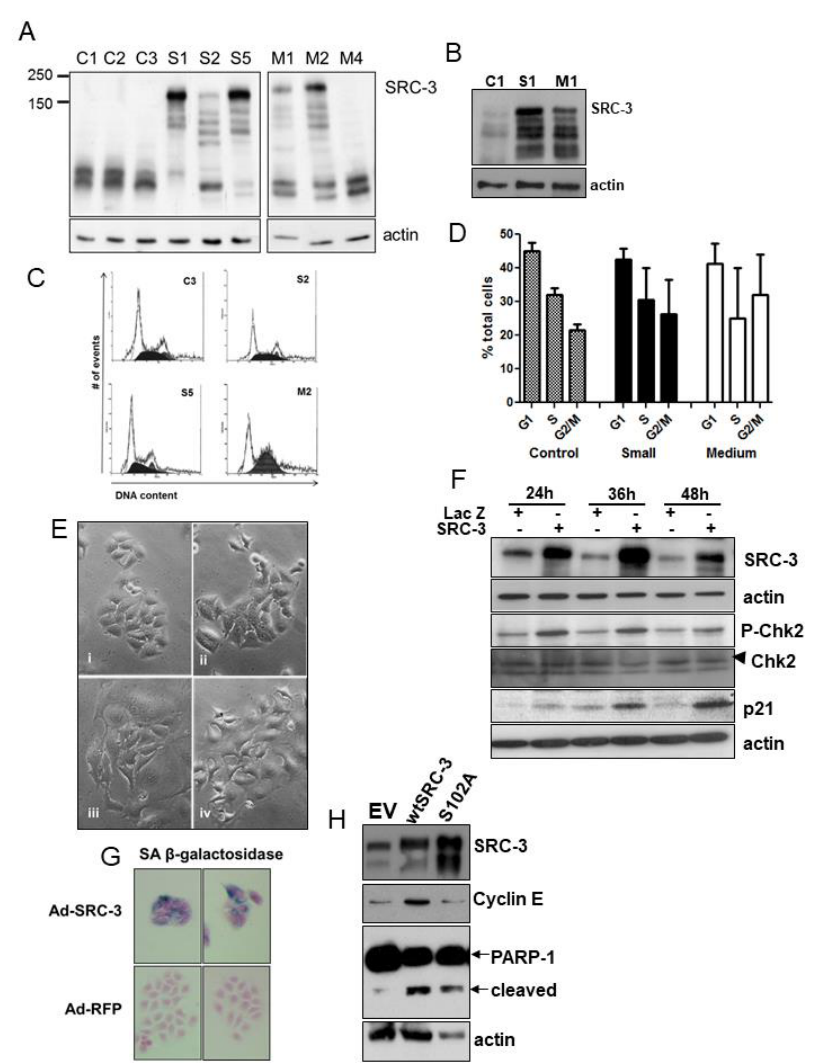
Figure 2. Establishment of SRC-3-overexpressing MCF-7 cells. ( A ) Immunoblot analysis showing SRC-3 protein expression in MCF-7 cells transfected with pCMX-RAC3 (SRC-3) or pcDNA3 and selected for puromycin resistance. SRC-3 stable cells were categorized according to the relative size of the average cell within a colony prior to expansion. Examples of clones that survived at least one passage are shown: control pcDNA3 cells (1,2,3), small-sized SRC-3 transfected clones (S1,2,5) and medium-sized SRC-3 clones (M1,2,4). Large cell clones did not survive passage. ( B ) Immunoblot of original clones showing SRC-3 expression relative to empty vector-transfected control. ( C ) Flow analysis of DNA content derived from the indicated clones. ( D ) DNA content graphs derived from the analysis of several clones. Bars are SD of means from: pcDNA control ( n = 4), SRC-3 small ( n = 15), SRC-3 medium ( n = 4). ( E ) Phase-contrast images of control pcDNA3- and pCMX-RAC3- (SRC-3) transfected MCF-7 cells. Panels are (i) Control clones, (ii) small SRC-3-overexpressing clones, (iii and iv) medium SRC-3-overexpressing clones which were enlarged and flat with abundant cytoplasm. ( F ) Cell lysates harvested after infection at the indicated times after infection with Ad-LacZ or Ad-SRC-3 were probed with antibodies to SRC-3, P-Chk2, Chk2 (denoted by arrowhead), p21 and actin. ( G ) MCF-7 cells infected with the Ad-RFP and Ad-SRC-3 viruses were cultured for 72 h and assayed for senescence-associated (SA) β -galactosidase activity. ( H ) Immunoblot for SRC-3, cyclin E and PARP-1 in MCF-7 cell lysates 72 h post-transfection with empty vector (EV), wtSRC-3 or the stable mutant SRC-3(S102A). Note that although highly expressed relative to wtSRC-3 and to the gel loading control, S102A does not induce transcription of cyclin E. Actin was used as a protein loading